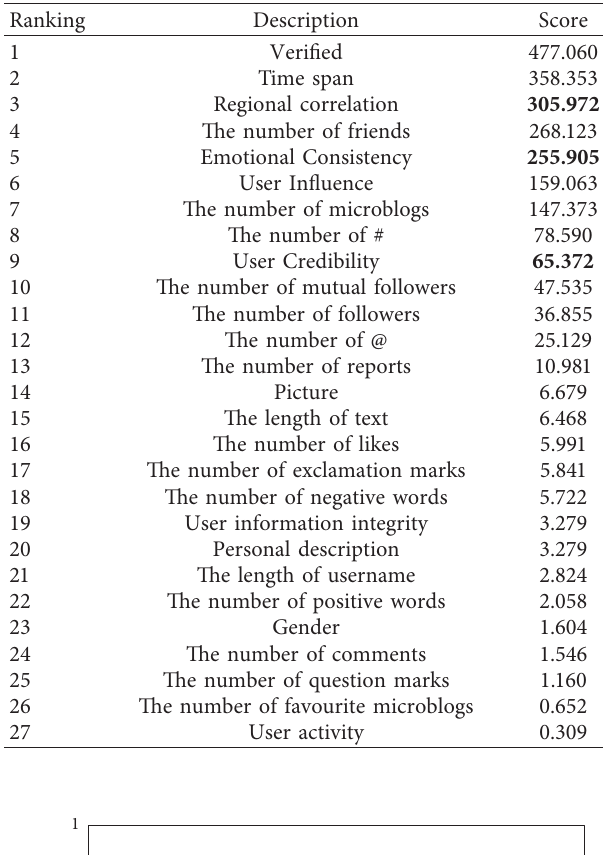
Table 1: Features ranking results.